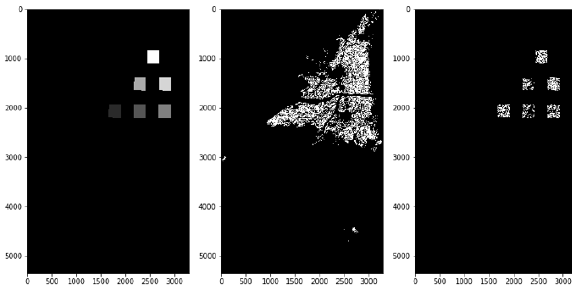
Figure 8. Sampling.